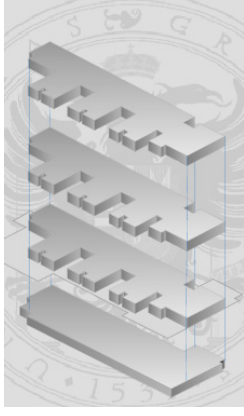
Figure 4. Sample building architecture.